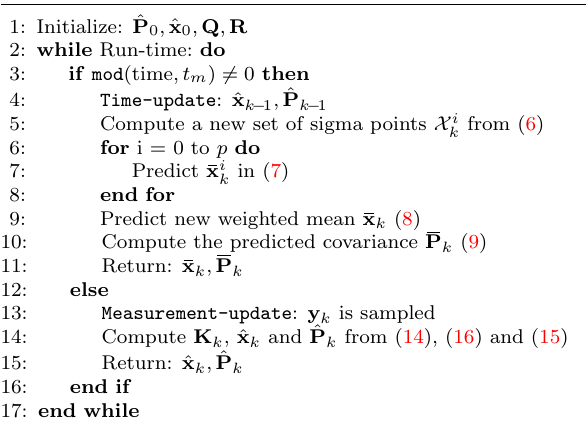
Algorithm 1 Unscented Kalman